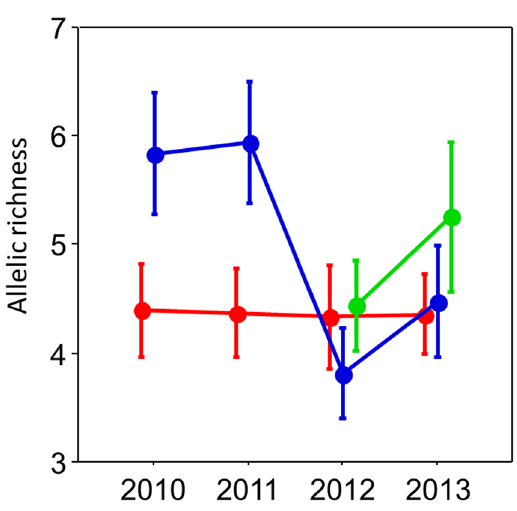
Figure 5. Allelic richness (mean ± SE) across the years, measured with 15 microsatellite loci. Red, blue, and green lines indicate the Gensui, Namaisawa and new-pool populations, respectively. Specimens in 2010 were collected before the tsunami, whereas those in 2011–2013 were collected after the tsunami. The allelic richness of each locus is shown in Supplementary Table